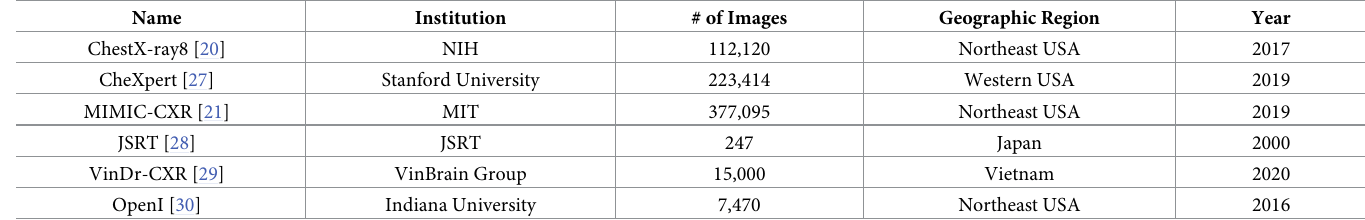
Table 1. Details of datasets included in this study.